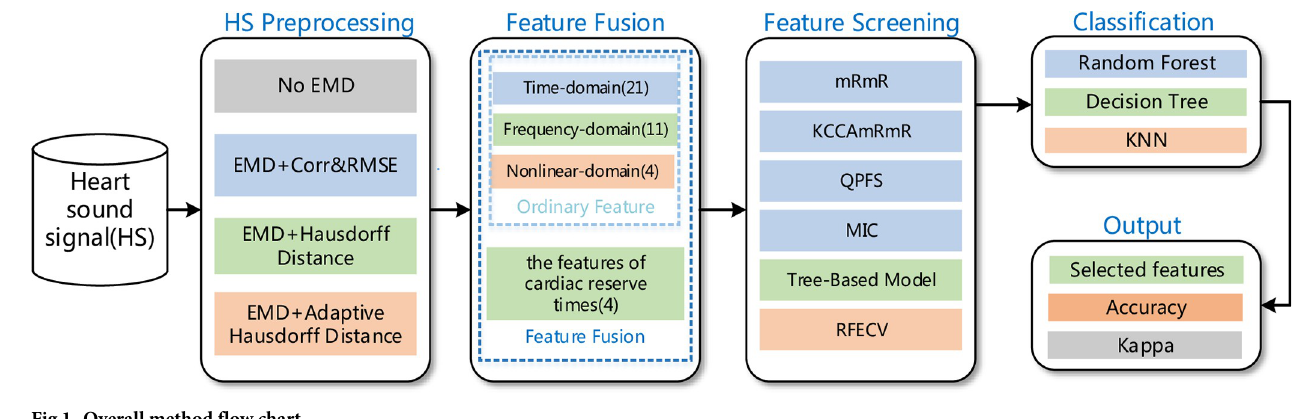
Fig 1. Overall method flow